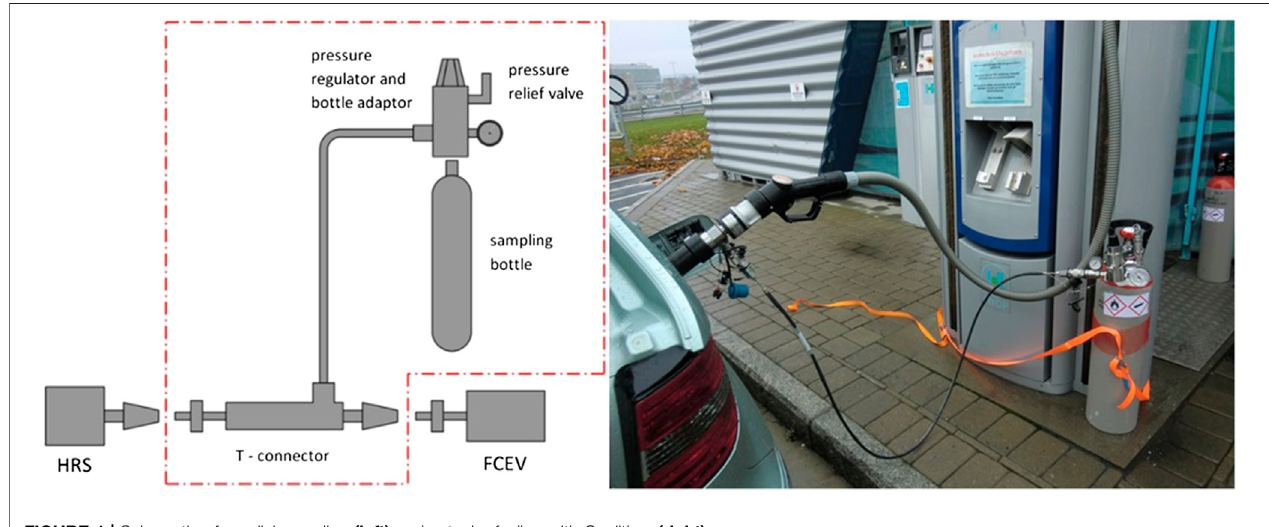
FIGURE 1 | Schematic of parallel sampling (left) and actual refueling with Qualitizer (right) .